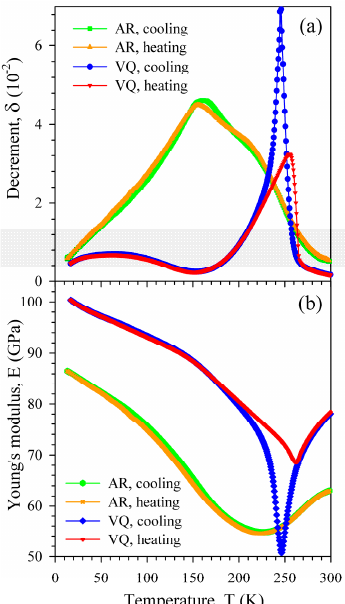
Figure 4. Temperature dependence of the decrement ( a ) and effective Young’s modulus ( b ) of the as-received (AR) and vacuum-quenched (VQ) Ni 50.8 Ti 49.2 samples measured in a cooling-heating cycle at strain amplitude of 10 − 6 .